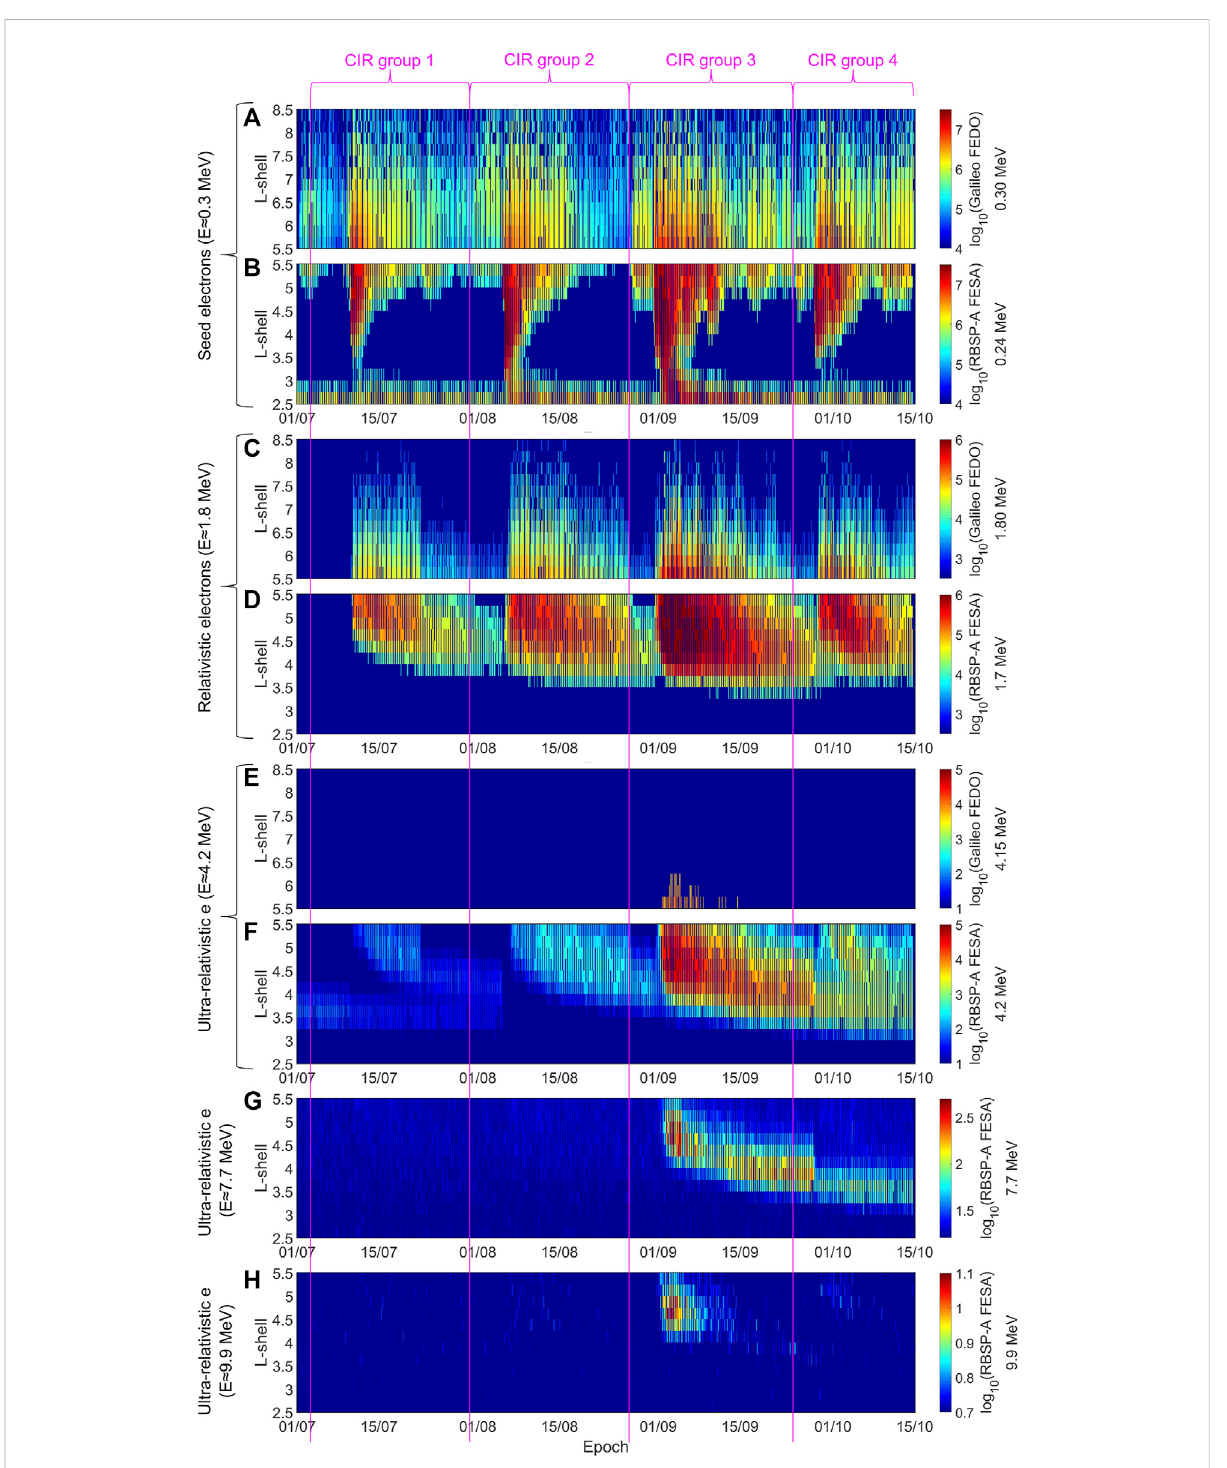
Thelogarithmofelectron fl uxintensity[(MeVcm 2 srs) − 1 ]forseed[E ≈ 0.3MeV,panels (A,B) ],relativistic[E ≈ 1.8 MeV (C,D) ]andultra-relativisticelectrons [E ≈ 4.2 MeV (E,F) ,E ≈ 7.7 MeV (G) ,E ≈ 9.9 MeV (H) ]usingdatafromVanAllenProbeAforL=2.5 – 5.5R E andfromGalileospacecraftforL=5.5 – 8.5R E ,binned for dT = 3 h, dL = 0.25 R E , for the time period of 1/7/2019 to 15/10/2019. The selected energy channels of each spacecraft are mentioned on the